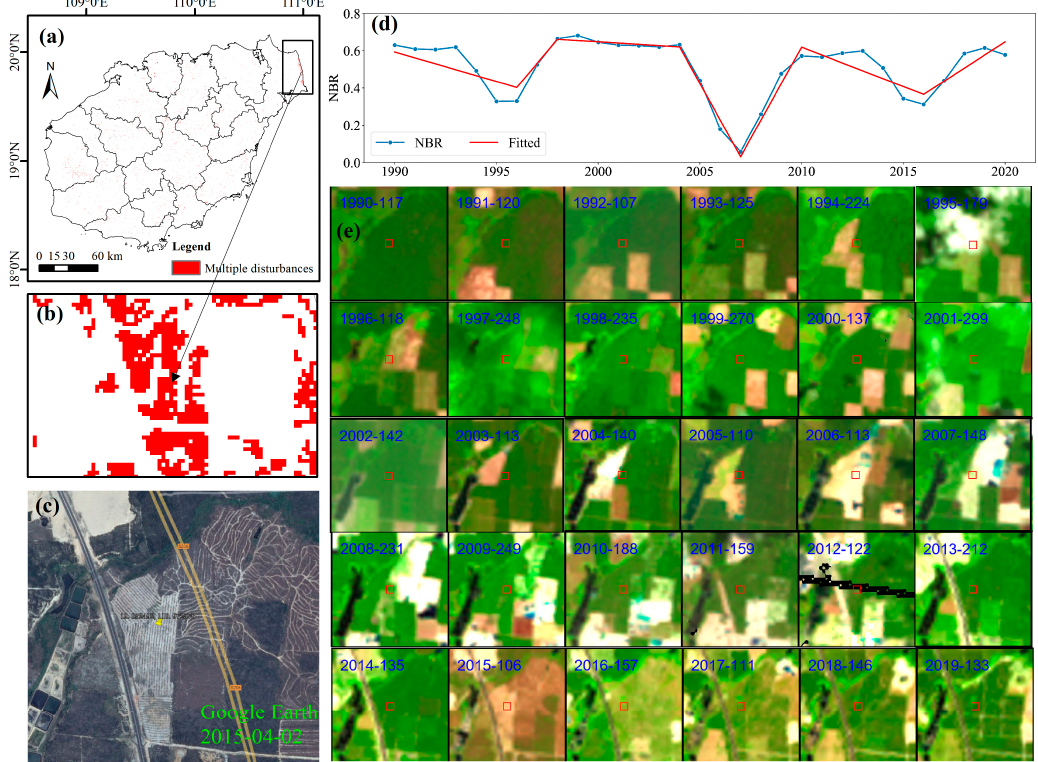
Figure 10. Schematic diagram of multiple forest disturbance monitoring: ( a ) map of multiple forest disturbances on Hainan Island, ( b ) zoom view of multiple forest disturbances along the coast of Wenchang City, ( c ) very high-resolution Google Earth satellite image of a typical disturbance area (110.97255° E, 19.85249° N), ( d ) corresponding annual NBR time series and fitted LandTrendr trajectory, and ( e ) thumbnails of historical satellite images.